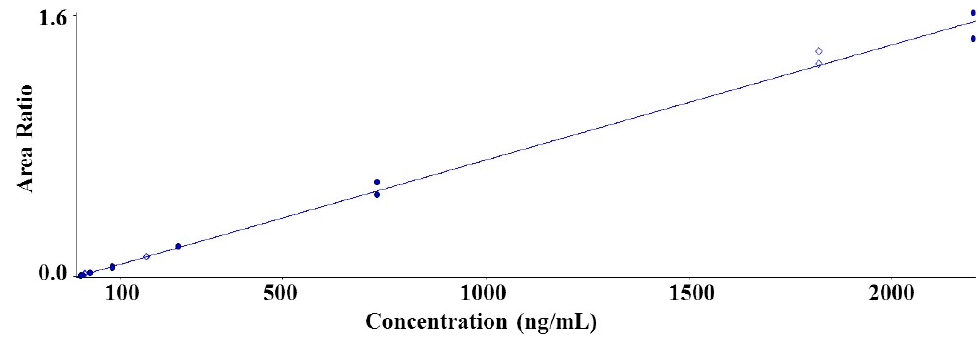
Figure 3. Representative calibration curve for SCH 58261 in rat plasma (r = 0.99414, range = 3.02~2200 ng/mL).